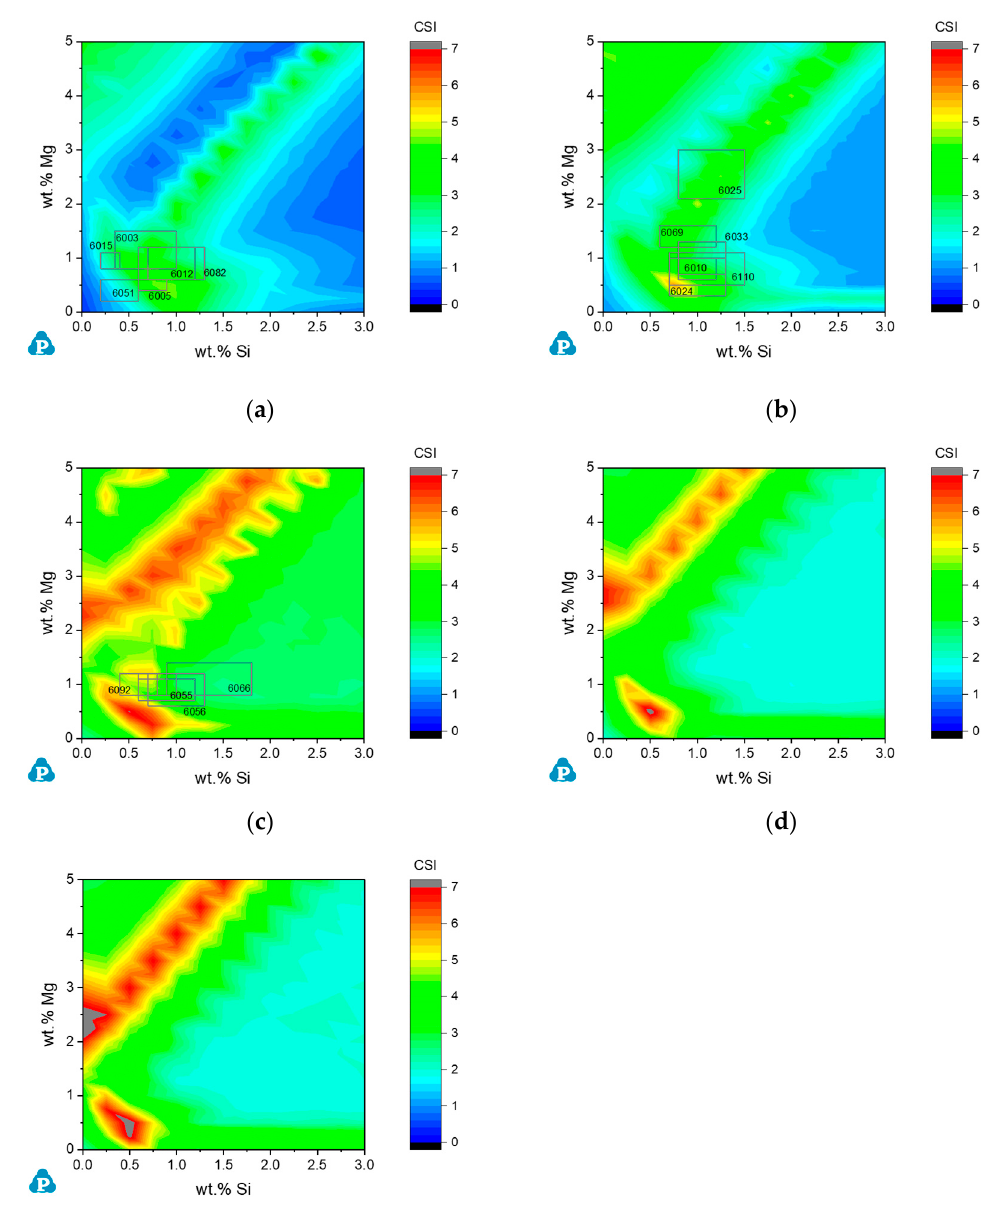
Figure 5. Calculated cracking susceptibility index ( CSI ) maps for AA6xxx alloys: ( a ) Al-0.6Fe-0.5Mn-0.2Zn- 0.2Cu -xMg- ySi; ( b ) Al-0.6Fe-0.5Mn-0.2Zn- 0.5Cu -xMg-ySi; ( c ) Al-0.6Fe-0.5Mn-0.2Zn- 1.2Cu -xMg-ySi; ( d ) Al-0.2Zn-1.2Cu-xSi-yMg; ( e ) Al-1.2Cu-xSi-yMg. Simulation is performed by improved Scheil model considering back diffusion in the solid under the cooling rate of 20 °C/s.